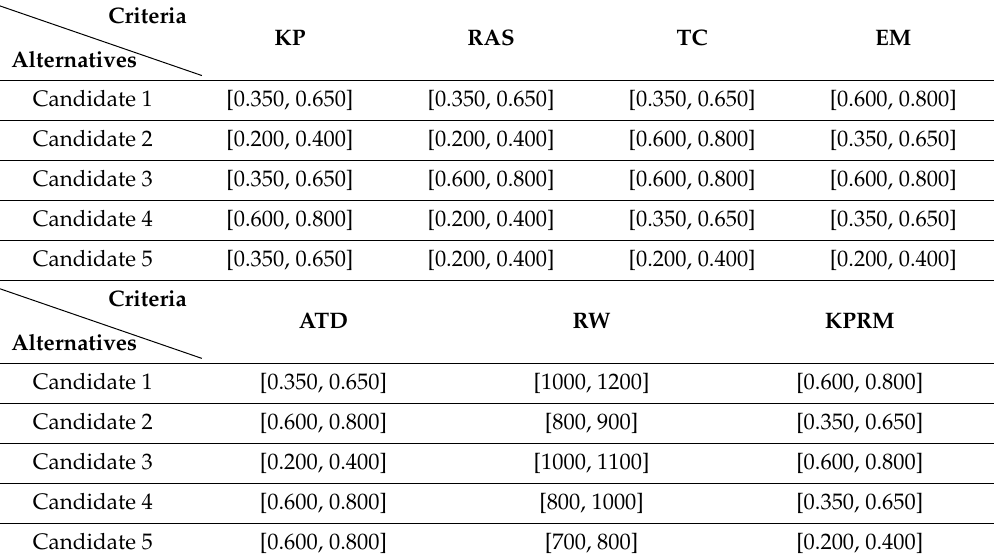
Table 9. The grey decision matrix.